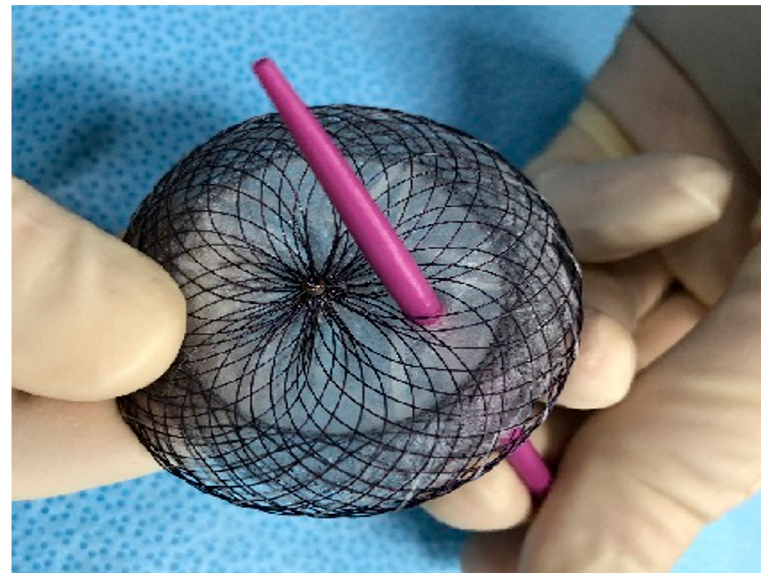
Figure 2. Fenestrated atrial septal defect.